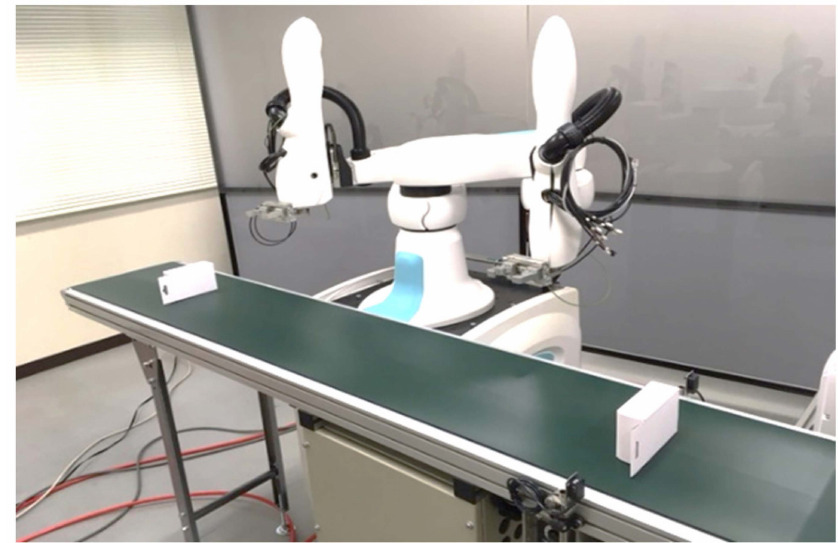
Figure 9. Experimental dual-arm robot system in pick-and-place